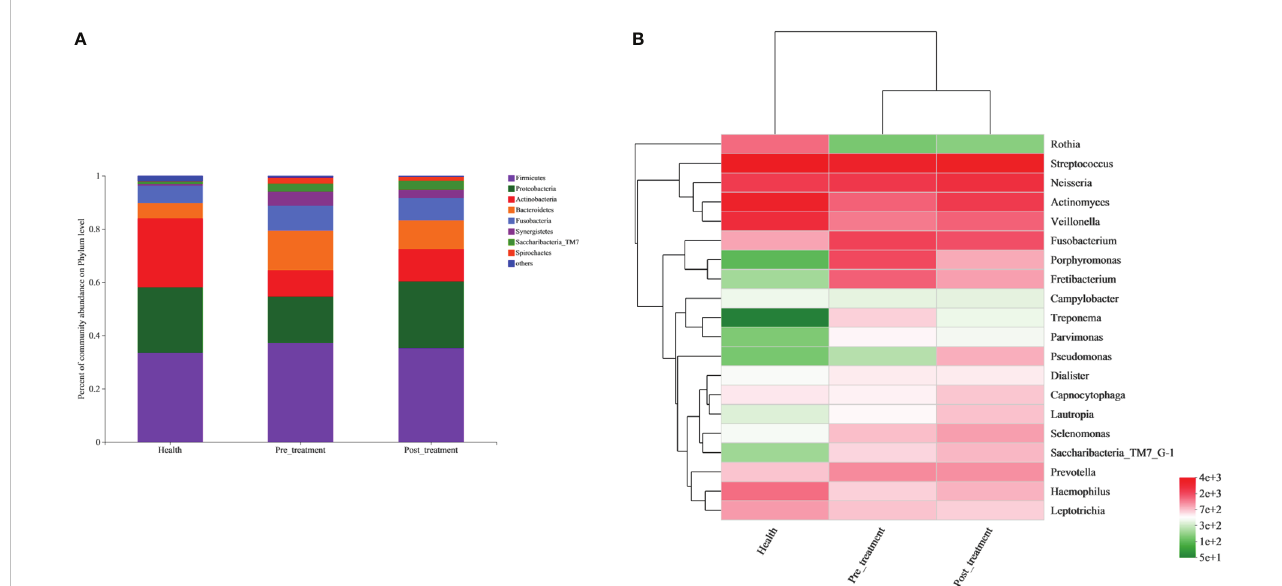
FIGURE 1 Compositions of the submucosal bacterial communities. (A) Relative prevalence of bacteria at the phylum level in healthy, pre-treatment, and post- treatment groups. (B) A heatmap showing the distribution of the top 20 genera across the three